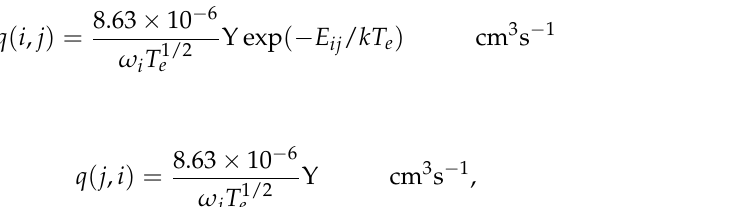
) transitions of He II. Broken curves are from the CC+CB programs, 7/2